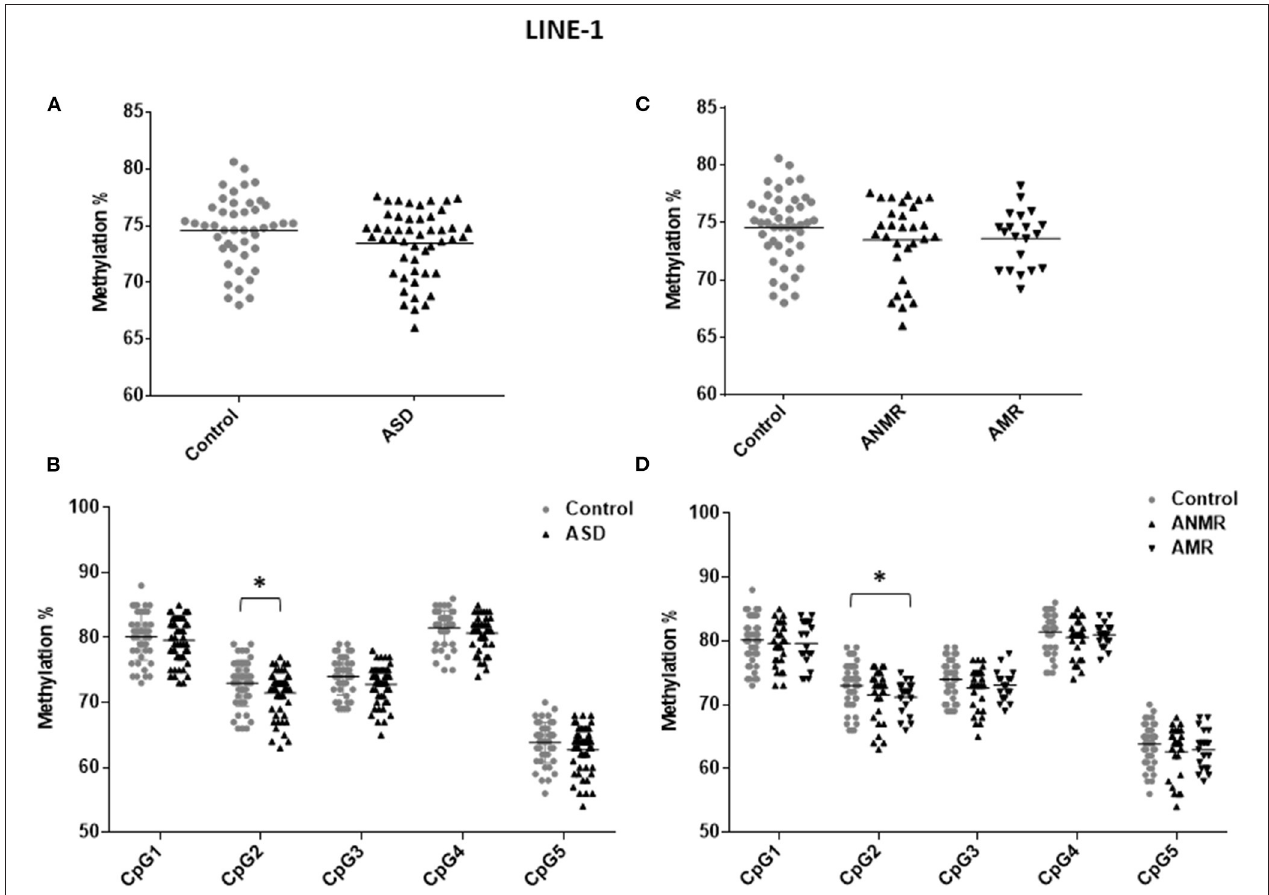
FIGURE 1 | Scatter plot showing comparisons of methylation status of LINE-1 in children with autism spectrum disorders (ASD) compared to controls. (A,B) Methylation levels and differentially methylated sites (CpG1–CpG5) in the LINE-1 sequence in ASD group and healthy control group. (C,D) Methylation levels and differentially methylated sites in the LINE-1 sequence in ASD group subdivided as follows: ANMR (non-mental regression group), AMR (mental regression group), and a healthy control group. The dark bars represent the mean values of each group. Asterisks indicate statistically significant differences (* P ≤ 0.05) compared to control group.